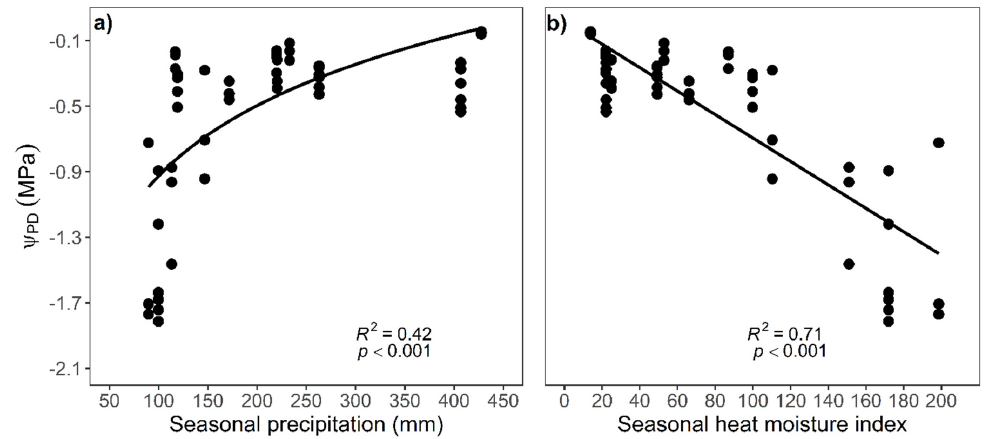
Figure 6. Relationship between pre-dawn water potential ( Ψ PD ) and ( a ) seasonal precipitation and ( b ) seasonal heat moisture index in Eucalyptus obliqua at the Wombat State Forest. The Ψ PD from three control plots and three impact plots (prior to the throughfall installation) was averaged to plot level for this analysis.